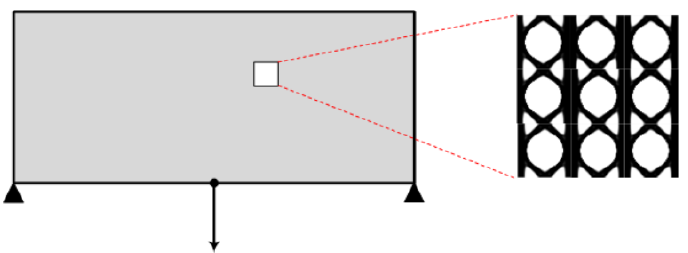
Figure 4. Optimized periodic unit cell for the bridge test example macro